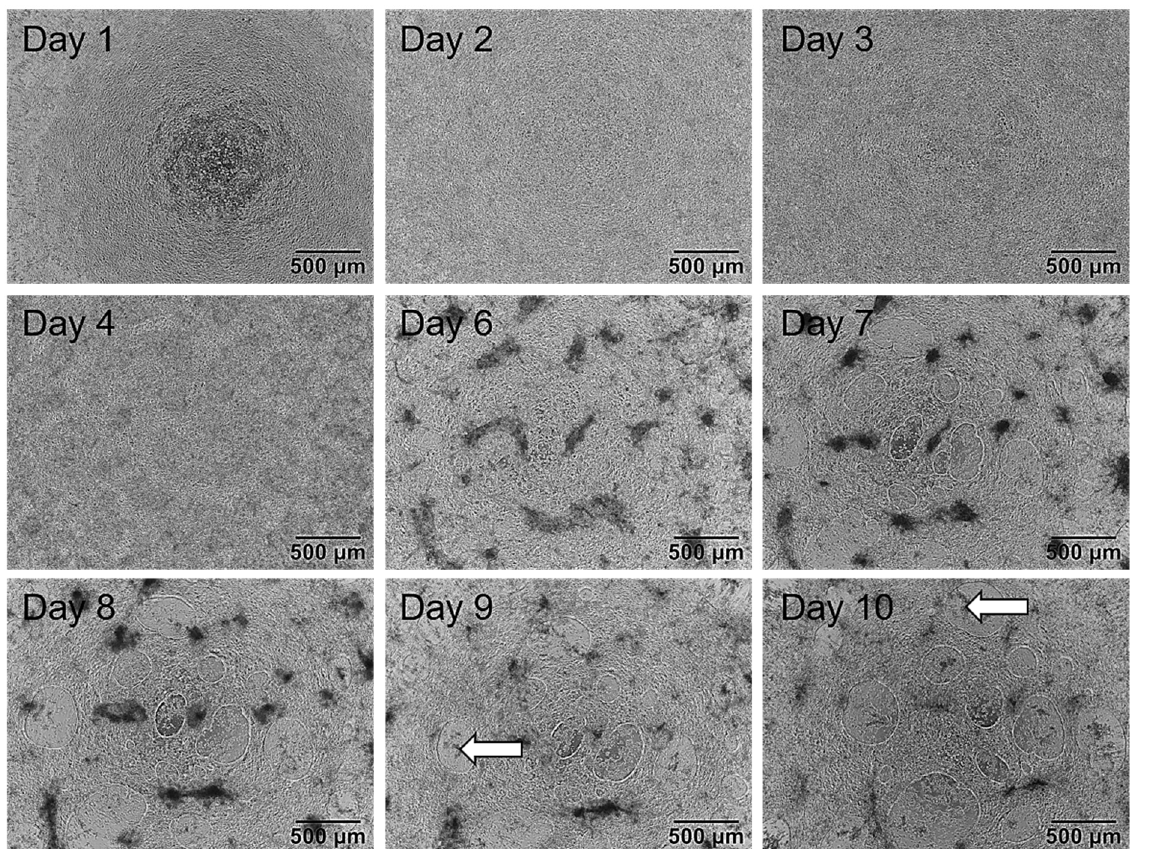
Figure 4. Exemplary phase-contrast images of the same well of human induced pluripotent stem cells (hiPSCs) differentiating into cardiomyocytes over a time course of 10 days. First, 2.75 × 10 5 cells/Matrigel (MG)-coated 48-well were plated on day 0 in ITS medium. Day 1: Medium was replaced with TS medium. Cells grew on top of each other. Day 2 and 3: Medium was changed to TS supplemented with 2 µ M IWP2. Cells grew to uneven heights. Day 4: Medium was changed to TS medium. On day 5 cells were not fed and not tracked. Day 6: TS medium was refreshed. Cells started to form holes and detached from the matrix. Day 7: Cells formed multiple holes and further detachement from the matrix was observed. Areas of beating cardiomyocytes were observable. Day 8: TS medium was refreshed. Cells started to beat in a wave motion. Day 9–10: The morphology of cells did not alter noticeably. The beating developed into a synchronous wave contracting over the entire well on day 10. Dead cells were trapped between the matrix and the beating cells not sucked in during feeding (white arrows). Images were taken with an Olympus CKX53SF (Tokyo, Japan) and an integrated camera SC50. Magnification: 40 ×